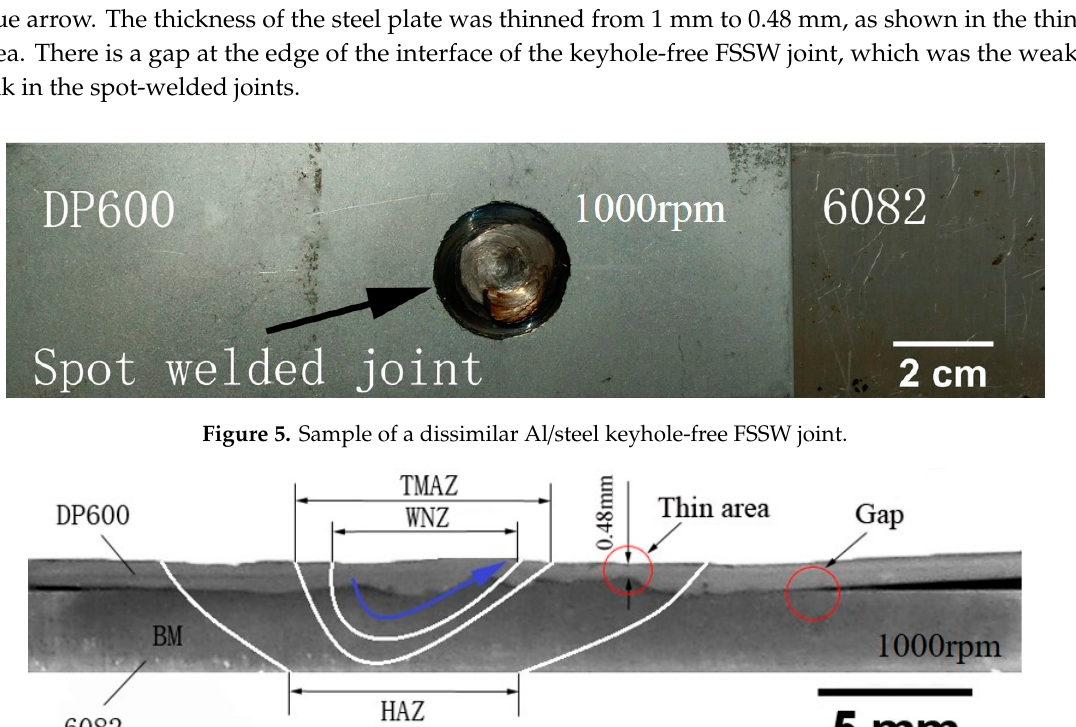
Figure 4. The real-time temperature–time curves ( a ) and histogram of maximum welding temperature ( b ) of dissimilar Al/steel keyhole-free FSSW process.